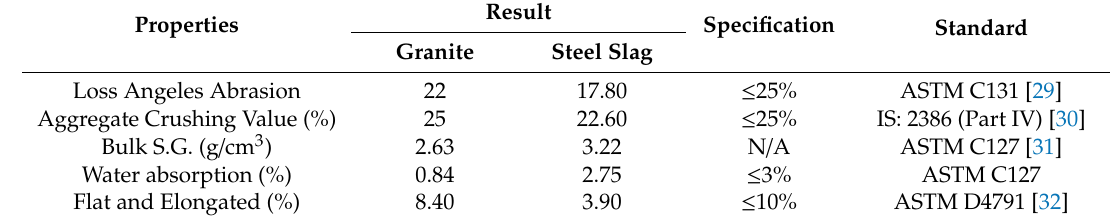
Table 2. The physical properties of the steel slag and granite aggregates.